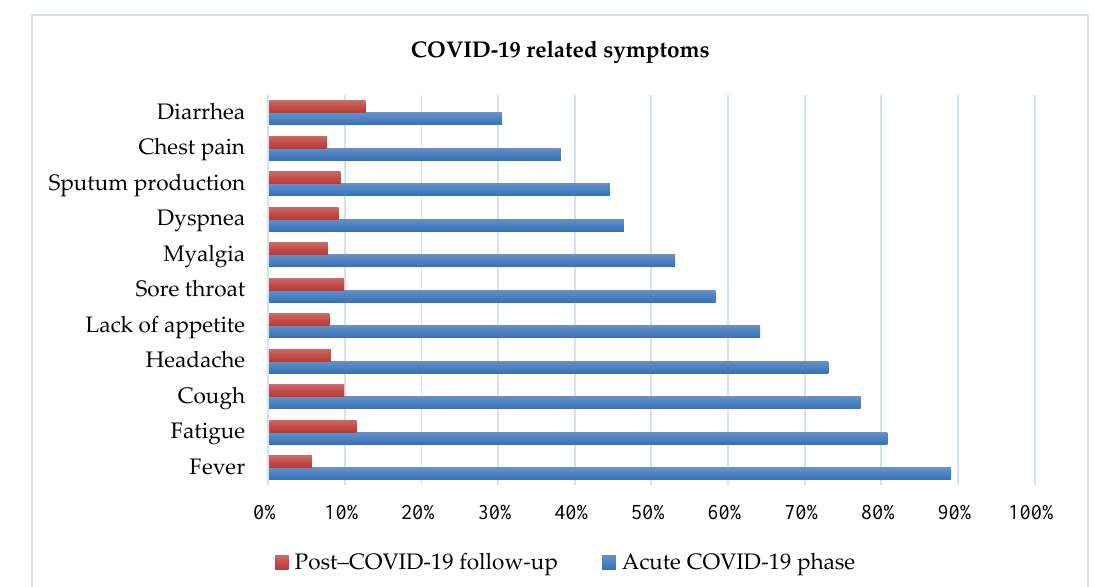
Figure 1. COVID-19-related symptoms during COVID-19 and post COVID-19 stage.